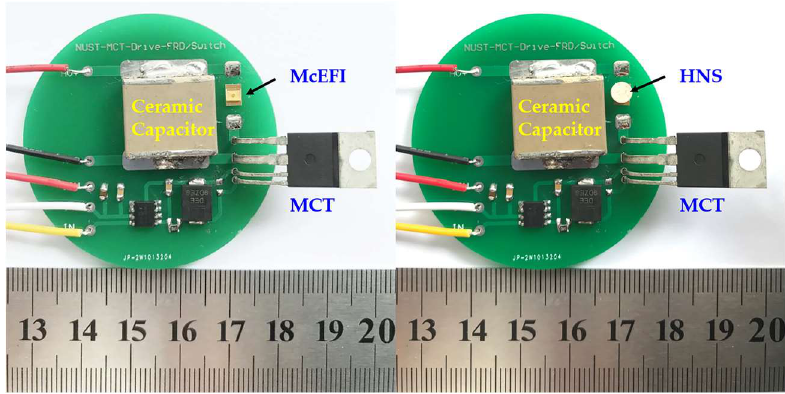
Figure 8. Firing device the CDU for initiating the HNS. Table 4. Initiation results of two kinds of HNS.